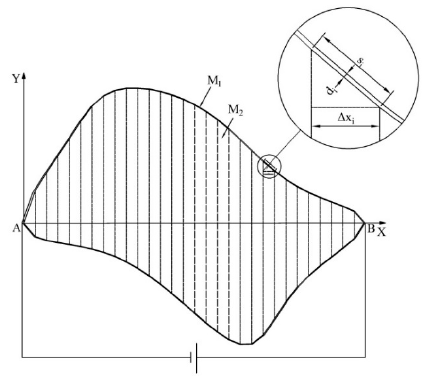
Figure 6. The structure of the irregular conducting plane.